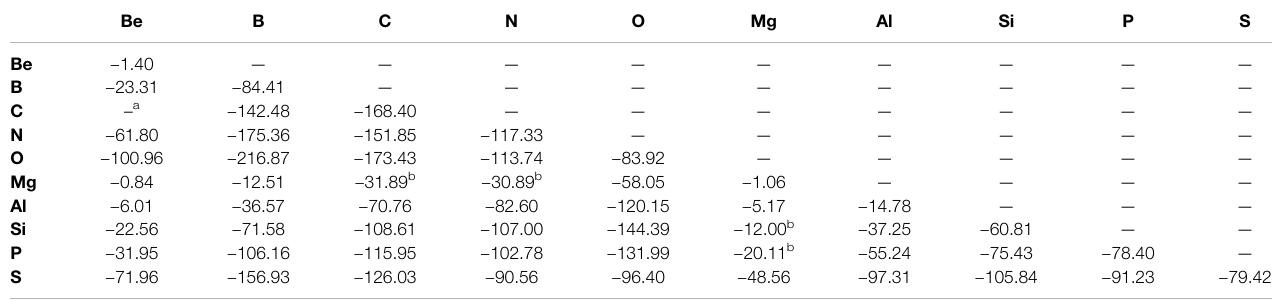
TABLE 1 | X (cid:1) Y Bond energies for “ Double-Bonded ” molecules (kcal/mol). Be